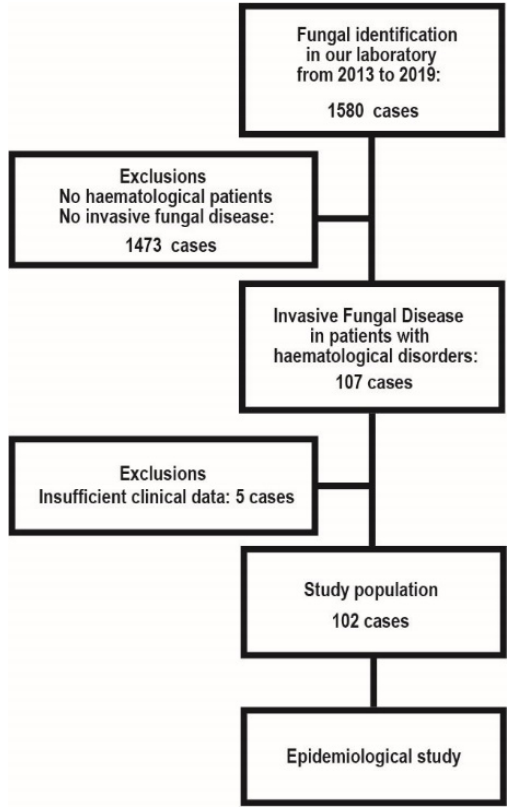
Figure 1. Study population and exclusion.